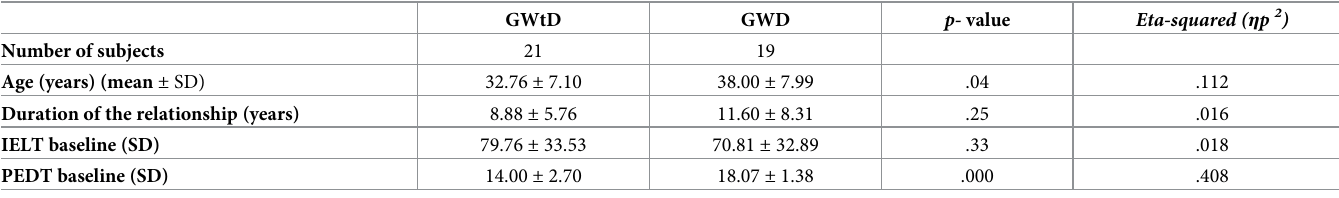
GWtD Group: SCT exercise program; Group GWD: SCT exercise program + electronic device SD: Standard deviation. P-value Student’s t-test independent samples Accepted level of significance p <